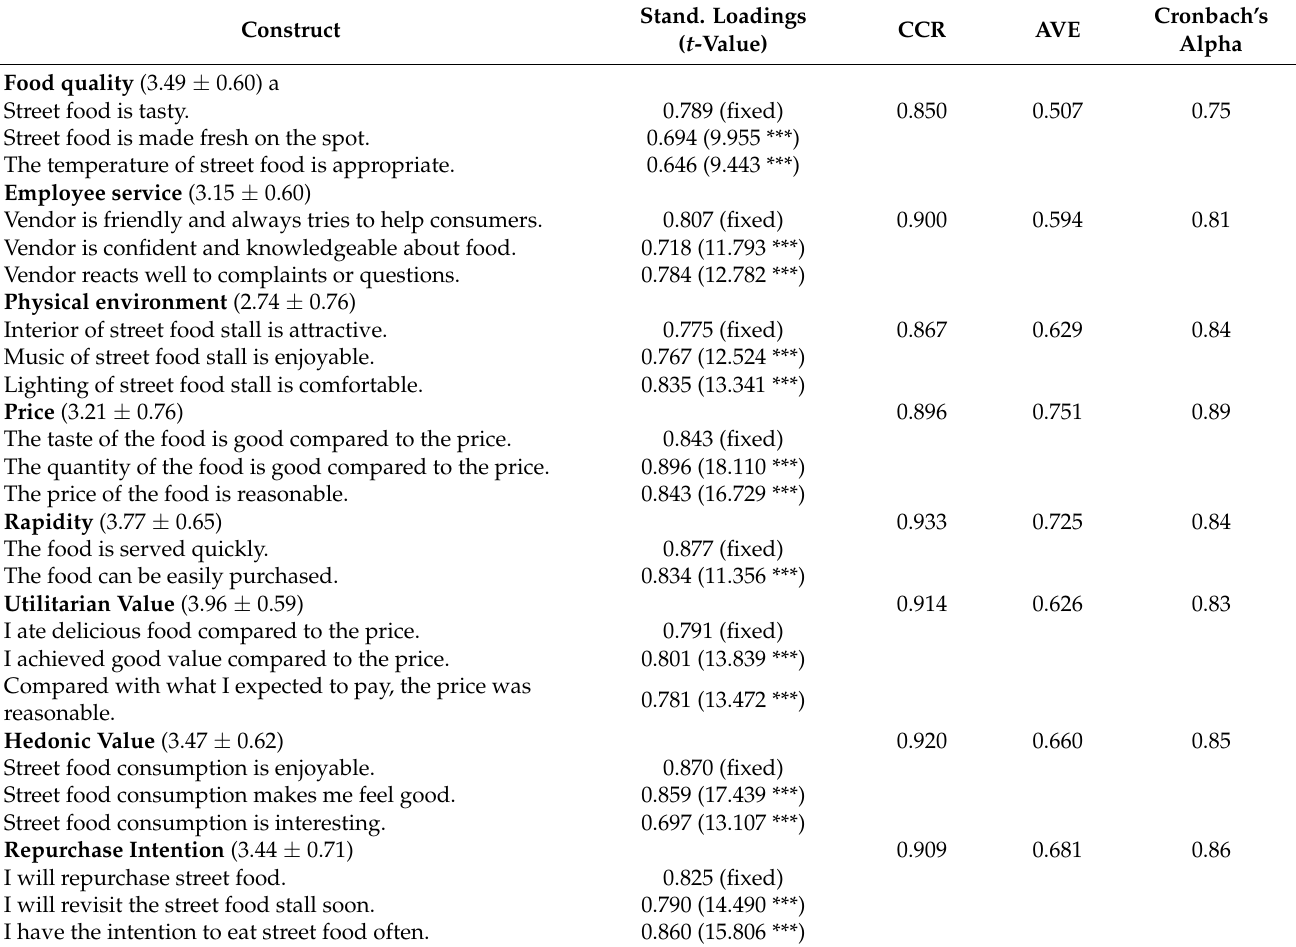
Table 2. Reliabilities and confirmatory factor analysis for the model.